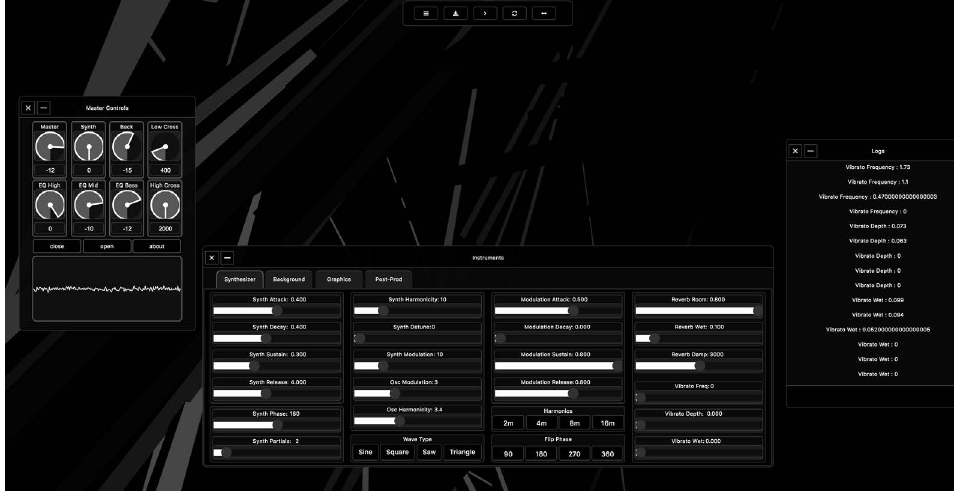
Figure 1: Akson AV Environment Graphic User